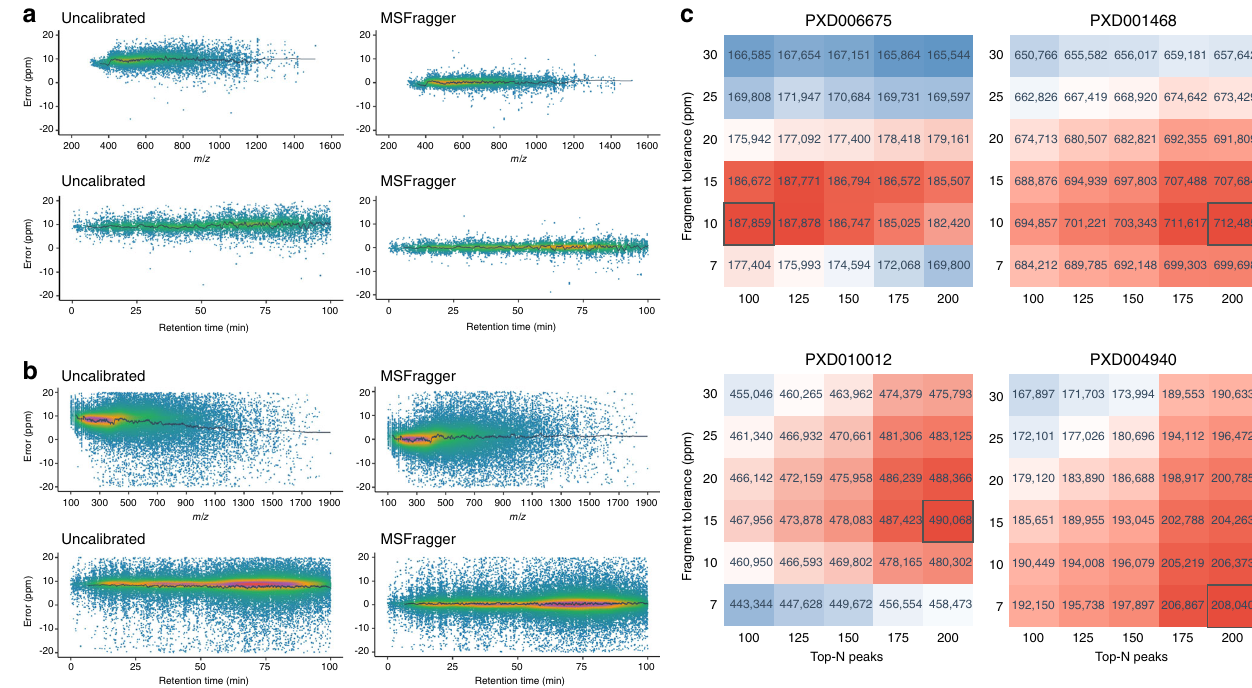
Fig. 2 Mass calibration and parameter optimization. a Precursor mass error before and after mass calibration, where color indicates point density. Precursor mass error is shown against m/z (upper panel) and retention time (lower panel). The smoothed moving average line is shown in dark gray. b Same as a , for fragment mass calibration. c Parameter optimization performance of MSFragger. Each heatmap shows the number of identi fi ed PSMs as a function of the fragment mass tolerance (rows) and the number of peaks used for matching (columns). The color of each cell indicates total PSMs (at 1% FDR) compared with the benchmark search result, where parameter combinations performing better than the benchmark are colored red and those with fewer PSMs are colored blue. The optimal parameters selected by the automatic procedure are marked with a black